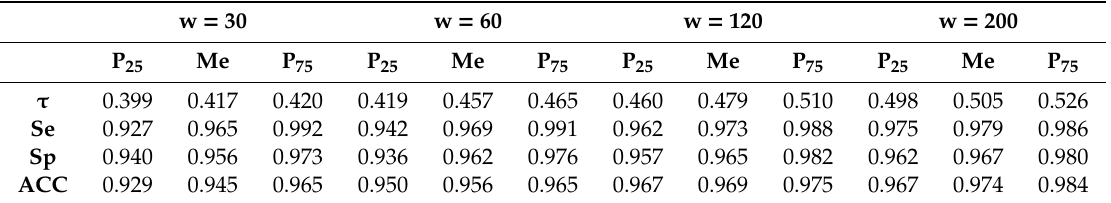
Table 2. Median and percentiles 25th and 75th values of threshold, Sensitivity, Specificity, and Accuracy for window size 30, 60, 120, and 200 of the 10-fold